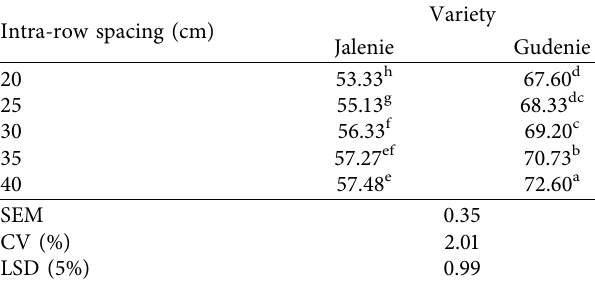
Table 4: Interaction effect of variety and intra-row spacing on days to 50% flowering of potato in 2013/2014 at Nono Benja. Intra-row spacing